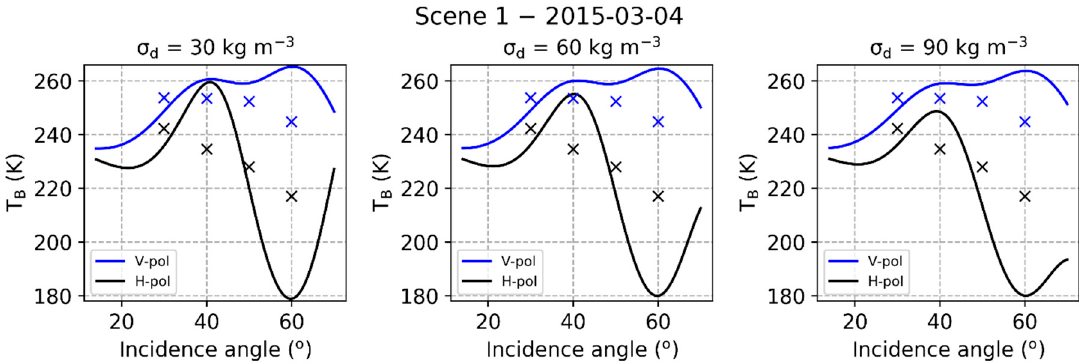
Figure 3. T B V-pol (blue) and T B H-pol (black) on 4 March 2015 at Scene 1 measured (symbols) and simulated (lines) with the Wave Approach for LOw-frequency MIcrowave emission in Snow (WALOMIS) with added Gaussian noise ( σ d ) to the measured density of 30 kg m − 3 ( left ), 60 kg m − 3 ( center ) and 90 kg m − 3 ( right ).